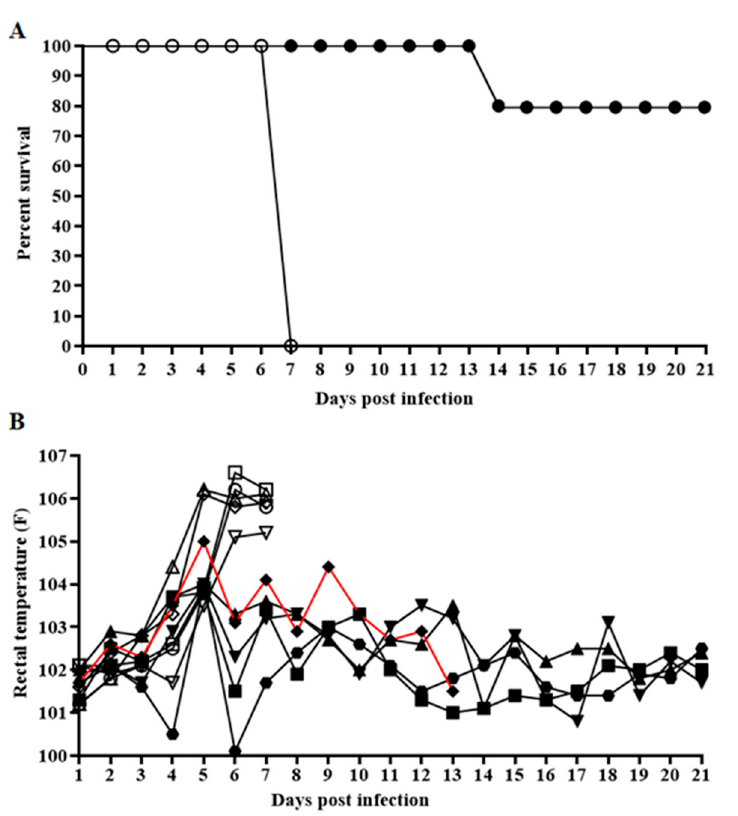
Figure 4. The evolution of mortality ( A ) and body temperature ( B ) in animals intransally (IN) infected with 10 5 TCID 50 of either E2 ∆ SERTAD1v (filled symbols) or parental BICv (open symbols). Animals were monitored for an observational period of 21 days post infection. In red is the evolution of the rectal temperatures of the only E2 ∆ SERTAD1v-infected animal euthanized at 14 days post infection (dpi). Circulating counts of white blood cells (WBCs), lymphocytes and platelets were analyzed, as they are known indicators of CSF severity (Figure 5). In BICv-infected animals, circulating WBC values dropped drastically by 4 dpi and either remained low or slightly increased until the animals were euthanized by 7 dpi. Animals infected with E2 ∆ SERTAD1v also showed a drastic drop in WBC values by 4 dpi, followed by a clear recovery by 11–14 dpi and a new drop by the end of the experimental period, with the exception of the animal euthanized at 14 dpi, in which counts remained low. Blood lymphocyte and platelets counts in BICv-infected animals also dropped by day 4 and continued to decrease until animals were euthanized at 7 dpi. A clear decrease was observed in blood lymphocyte and circulating platelet counts by days 4 and 7 post infection, respectively, in E2 ∆ SERTAD1v-infected animals, with this transient drop followed by a return to near-normal values by 11–14 dpi, followed by a slow decrease in numbers at the end of the observational period. As happened with circulating white cell counts, blood lymphocytes and circulating platelet values in the E2 ∆ SERTAD1v-infected animal euthanized at 14 dpi remained low until death. In summary, infection with E2 ∆ SERTAD1v provoked a gradual decrease in hematological values that occasionally returned to baseline values during the 21-day observational period. This indicates that E2 ∆ SERTAD1v-infected animals still retain some degree of virulence even though the animals do not present clinical signs of the